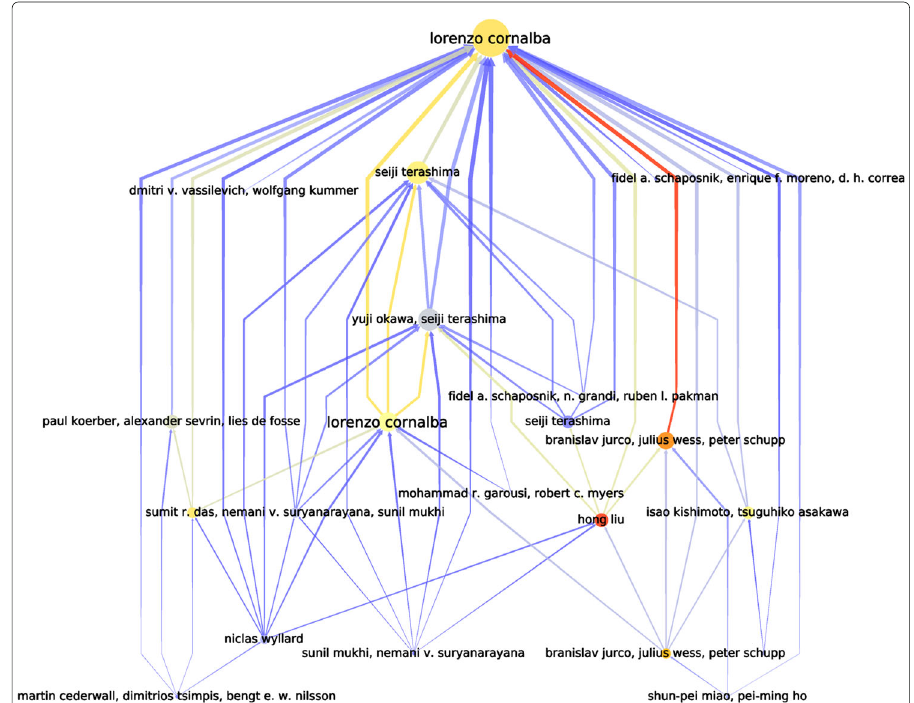
Fig. 4 An example of the ascending flow metric in an excerpt of 22 nodes (60 edges) of our dataset, rooted by a publication by Lorenzo Cornalba. The size of nodes corresponds to their ascending flow in this subgraph. The color of nodes and edges (from blue to red ) is actually their ascending flow in the real global dataset — we can see that Hong Liu’s publication has probably been a seed for more knowledge than of its ancestor Lorenzo